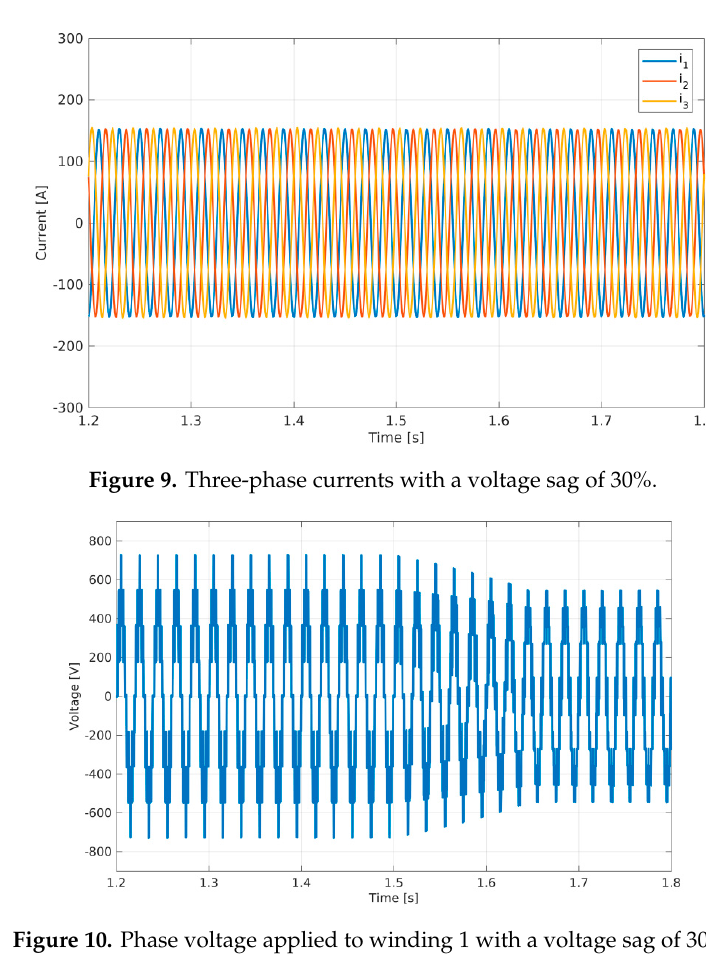
Figure 8. In the DC sides of the two inverters with a voltage sag of 30%.